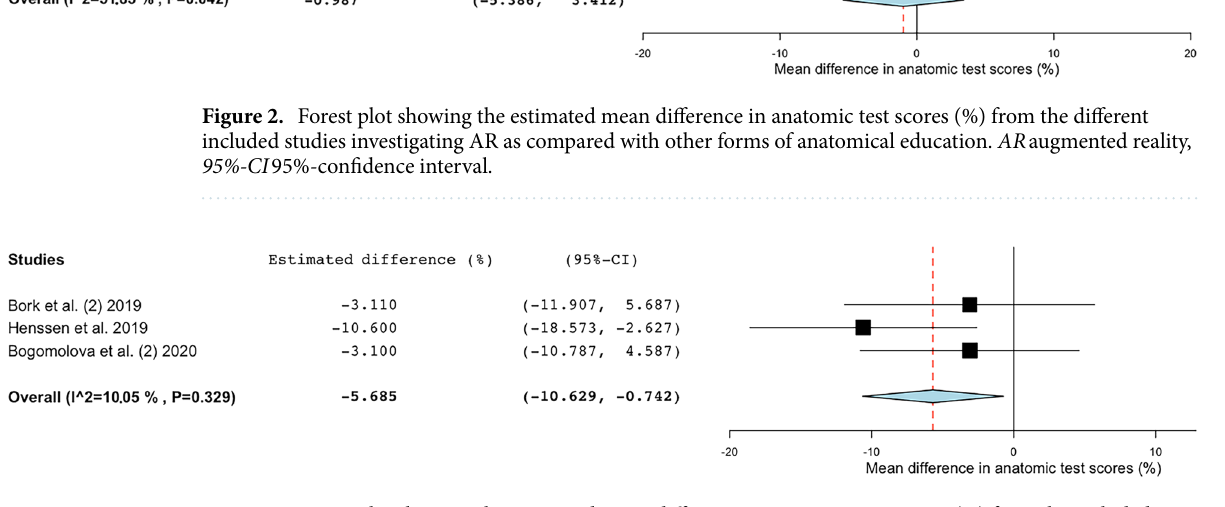
Figure 3. Forest plot showing the estimated mean difference in anatomic test scores (%) from the included studies addressing AR vs. 2D forms of anatomical education (i.e., traditional anatomical atlases, radiological data). AR augmented reality, 95%-CI 95%-confidence Interval.